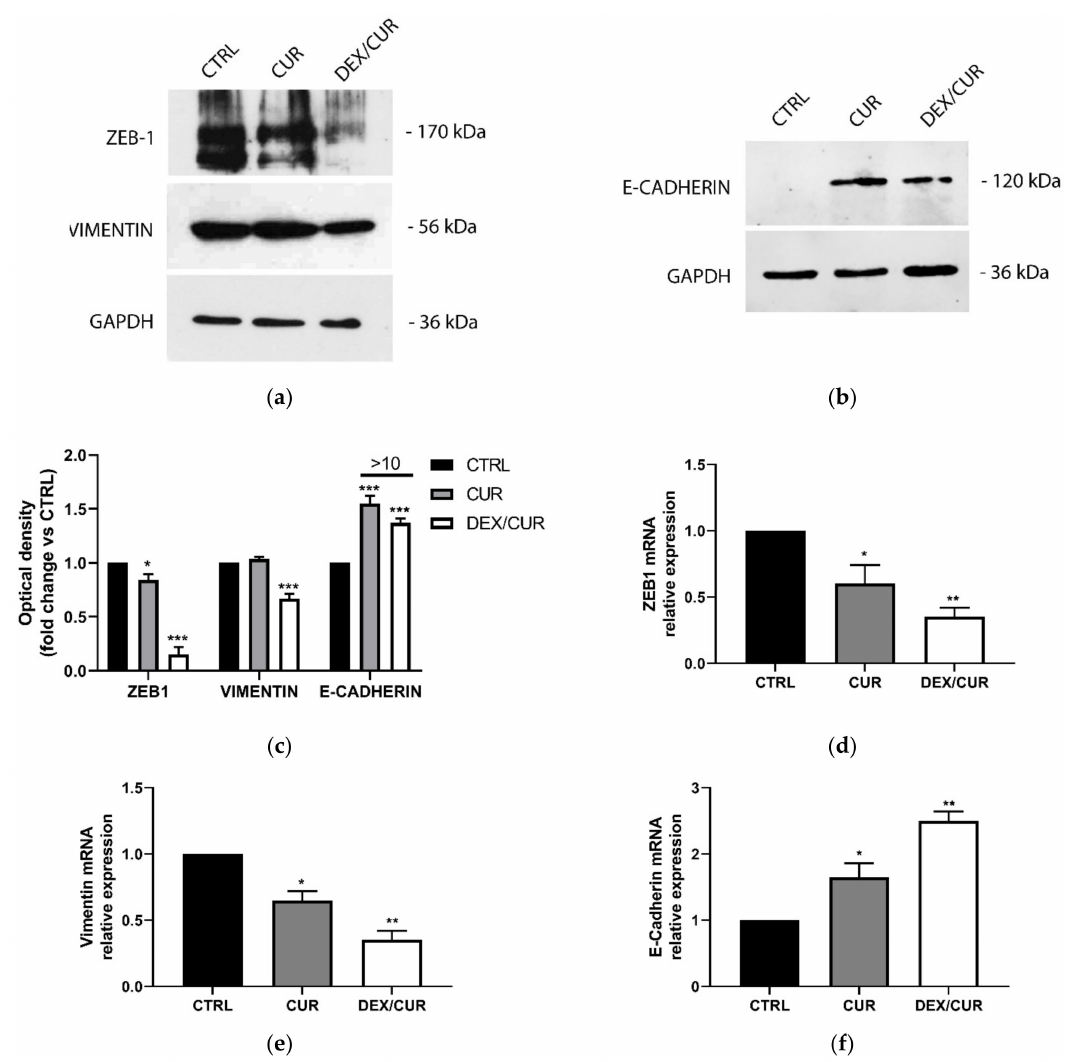
Figure 7. ( a , b ) Western blot, ( c ) Western blot quantitative densitometry analysis, and ( d – f ) qRT-PCR evaluating the mRNA levels of ( a , d ) ZEB-1, ( a , e ) Vimentin, and ( b , f ) E-cadherin after 48 h treatment with CUR and DEX/CUR at 20 µ M CUR equivalent concentration. GAPDH levels were used as control protein for WB and as internal control gene for qRT-PCR. Data were reported as mean values ± SD of three independent experiments. ( d – f ) one-way and ( c ) two-way ANOVA followed by Dunnett’s method: * p < 0.01, ** p < 0.001, *** p < 0.0001 vs.